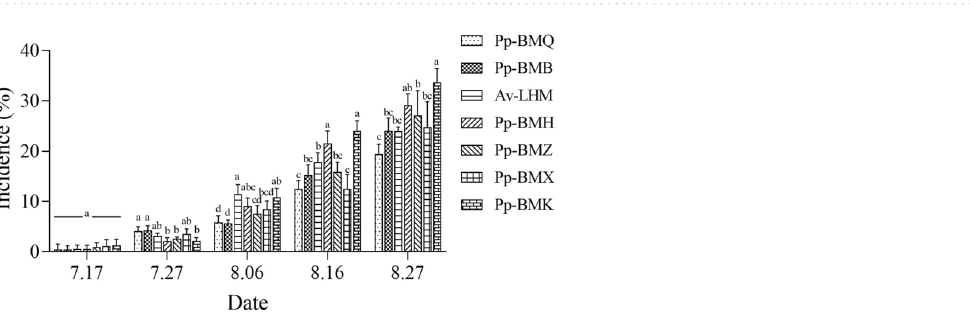
Figure 5. The incidence of seven ecotypes stem necrosis lesions disease caused by B. exigua var. rhapontica in 2020 in the